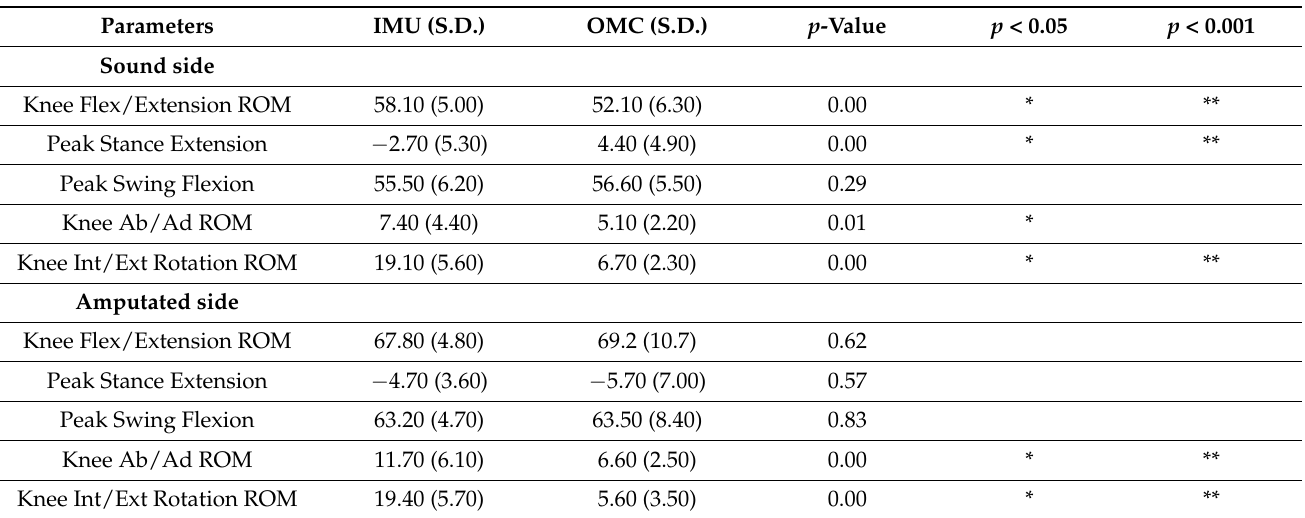
Table 5. Knee joint angle parameters of thirty participants on sound and amputated side as mean (S.D.) over five gait cycles calculated by the IMU and